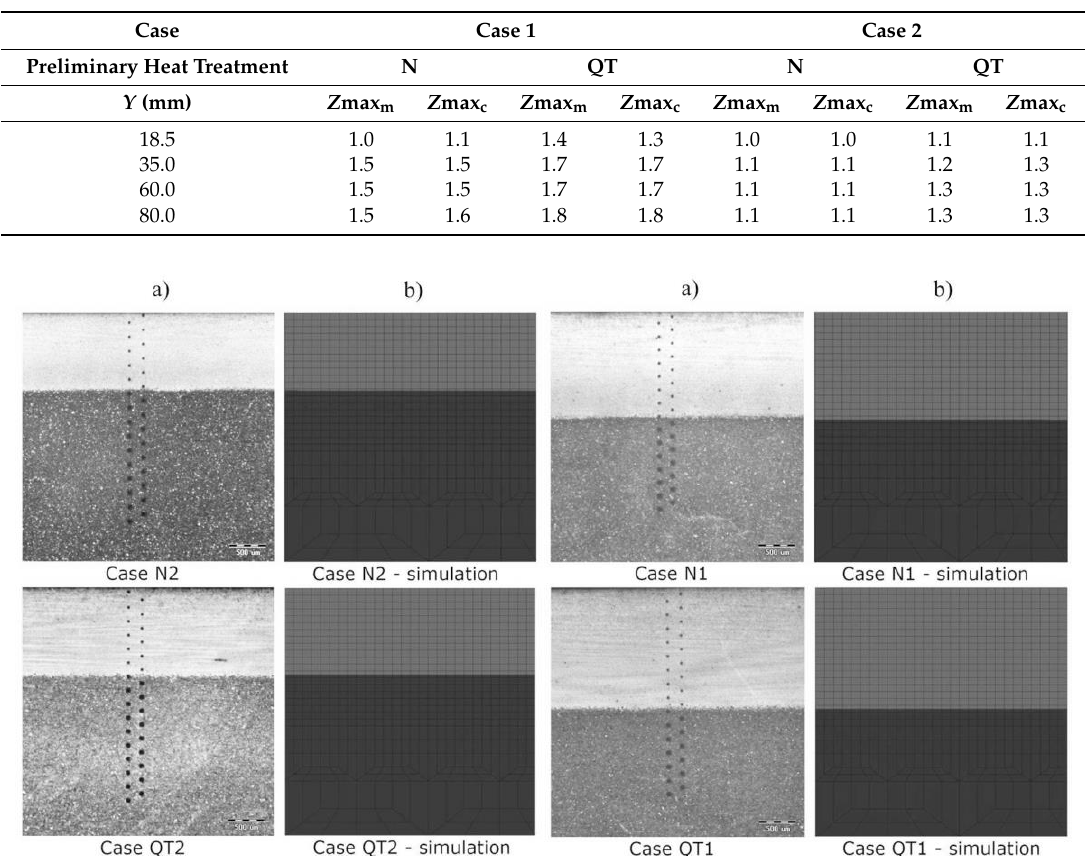
Table 10. Measured ( Z max m ) and computed ( Z max c ) maximum depths of the increased hardness for four cases.